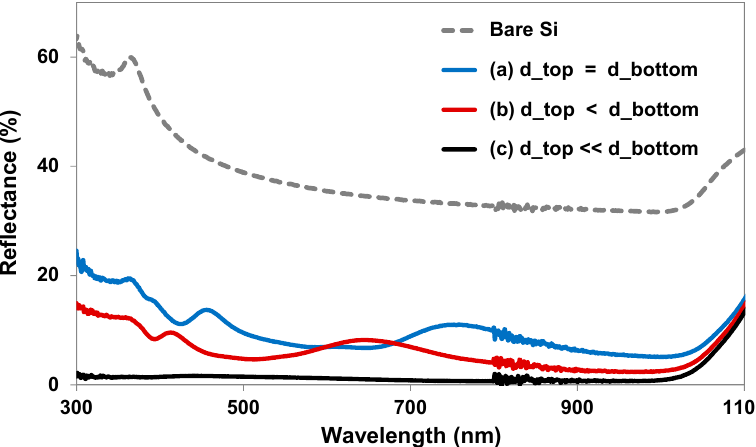
Figure 7. Measured reflectance of Si nanostructures with different top diameters.